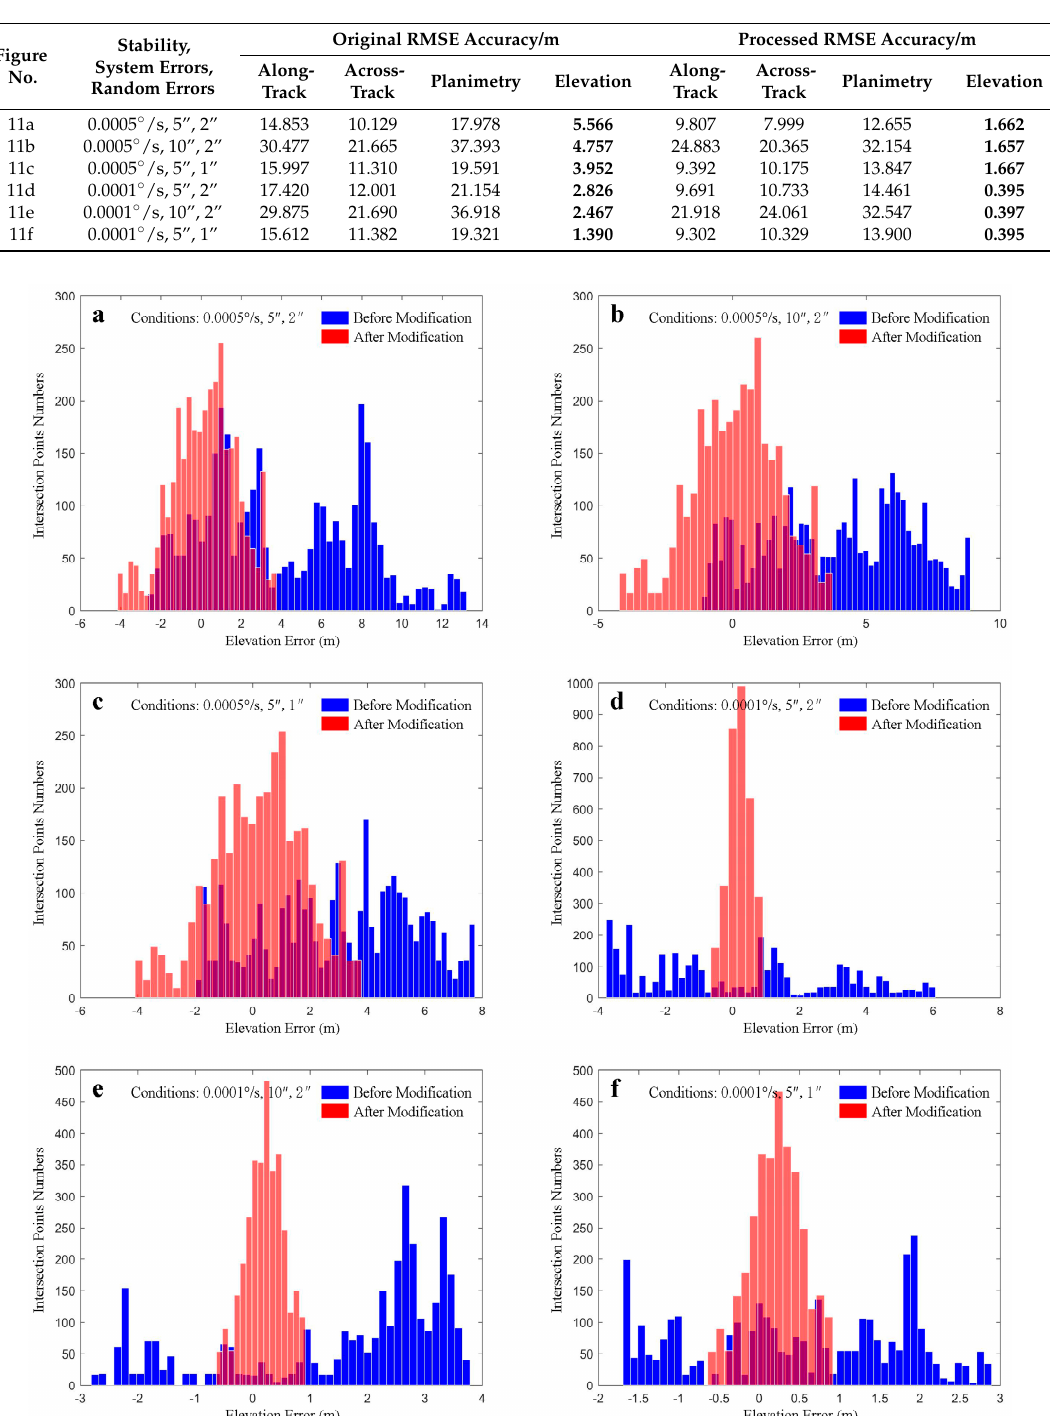
Table 5. Vertical accuracy statistics.